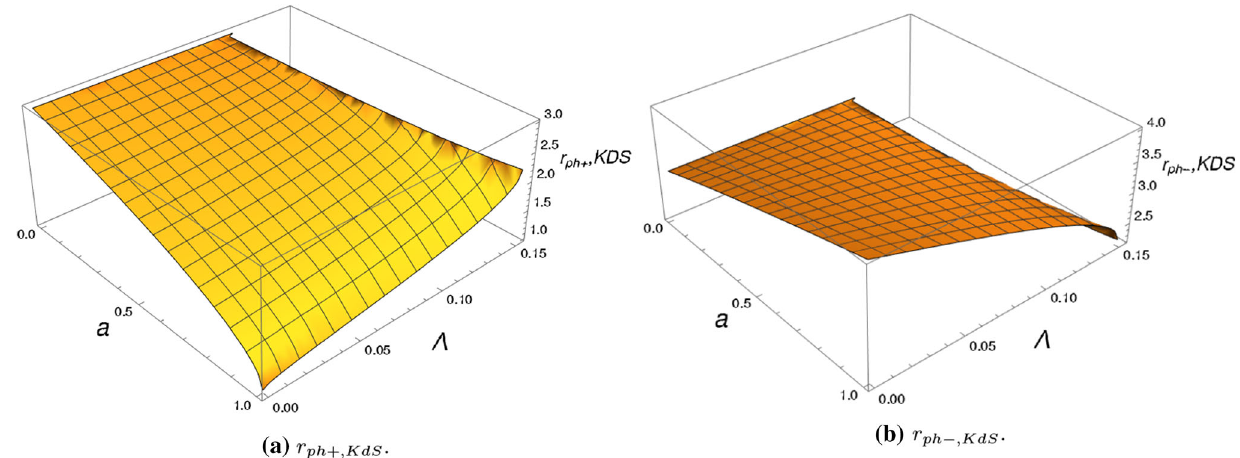
Fig. 2 Behaviour of radius of the equatorial circular photon orbit, r ph − , KdS and r ph + , KdS , for a ∈ [ 0 , 1 ] and (cid:2) ∈ [ 0 ,(cid:2) Max , KdS ] . As the blackholespinincreases, r ph + , KdS decreaseswhile r ph − , KdS increases.